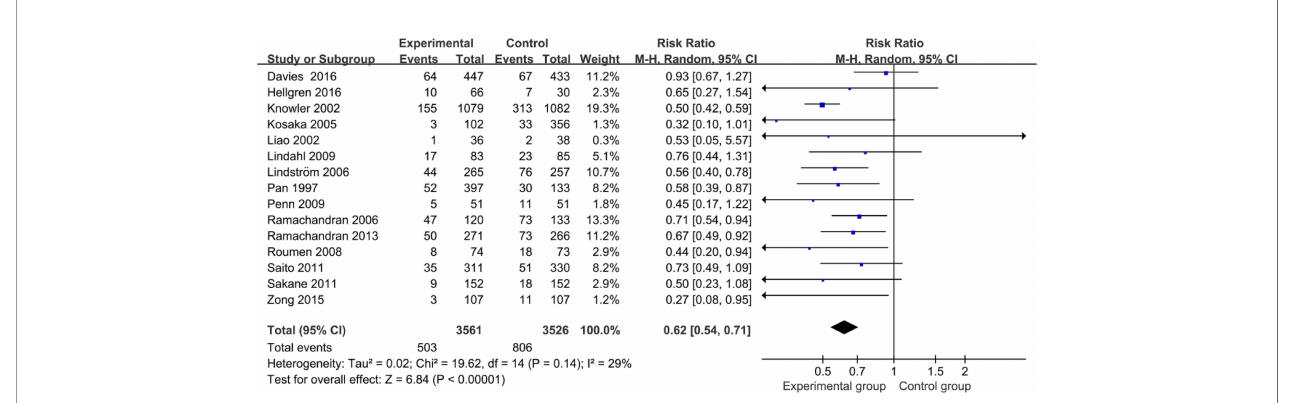
FIGURE 2 | Forest plot of diabetes incidence in intervention